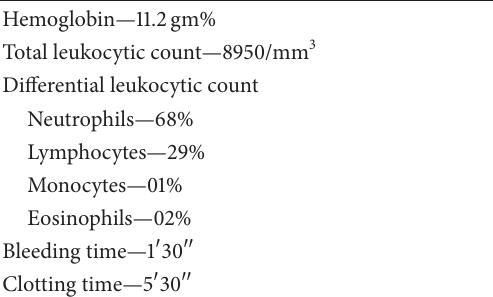
Figure 2: Tissue after